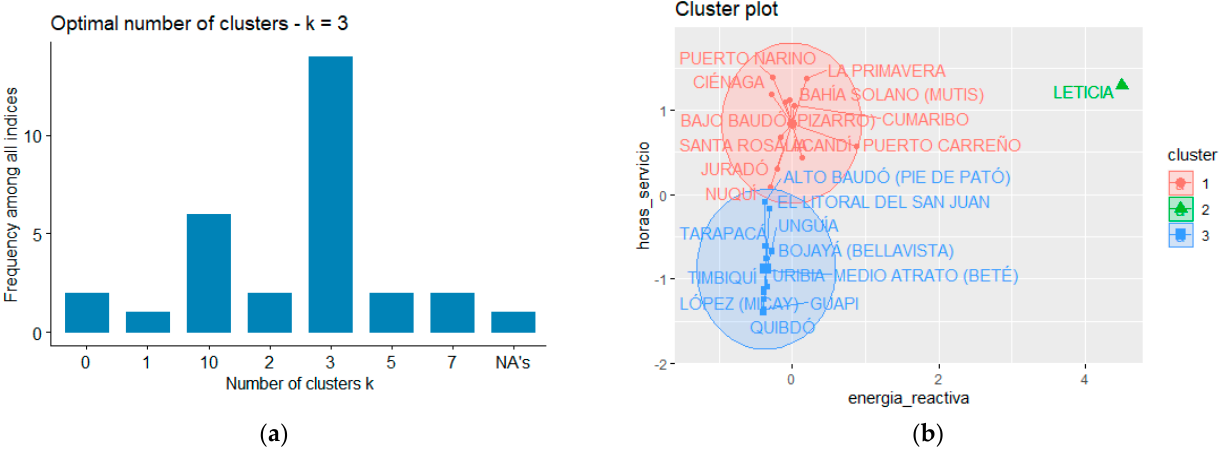
Figure 7. ( a ) Optimal number of clusters; ( b ) clusters by K-means algorithm (municipalities, operating hours per day, and reactive power). Table 5. Representative means of the municipality clusters by K-means. Cluster